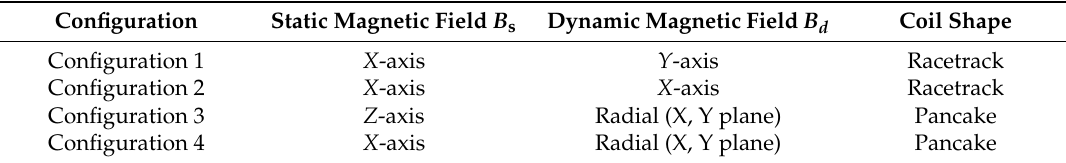
Table 2. Summary of the configurations used to study di ff erent magnetic field combinations.